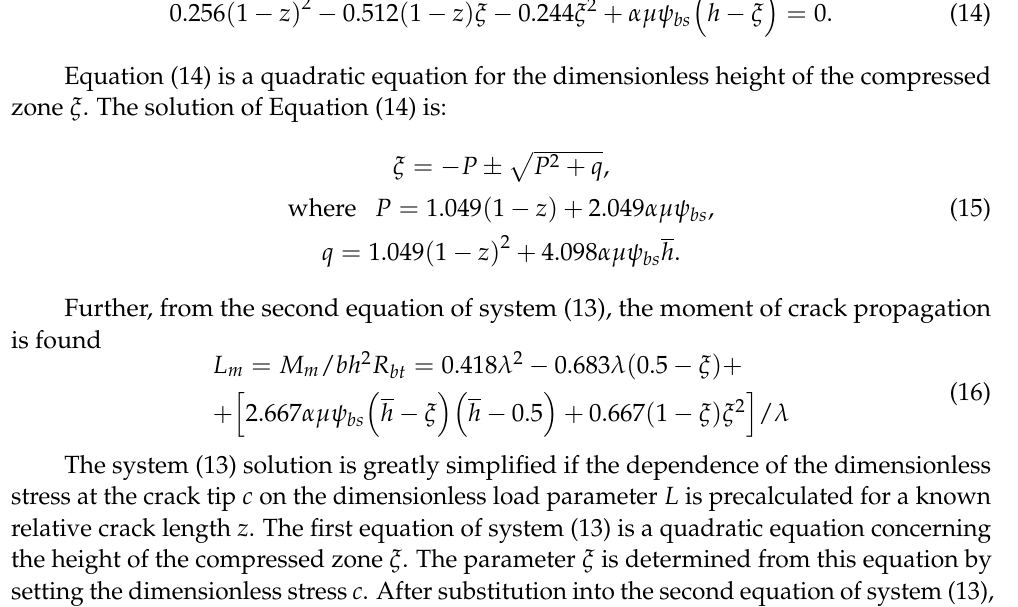
Figure 4. Dependence of the tension side height λ on the stress at the crack tip c : 1 on z = 0.1; 2 on z = 0.2; 3 on z = 0.3. Such a solution to system (13) is valid as long as the nominal stress σ m is less than or equal to the tensile strength of concrete bt R . Otherwise, the initial crack length will increase. The new crack length, corresponding to the effective moment